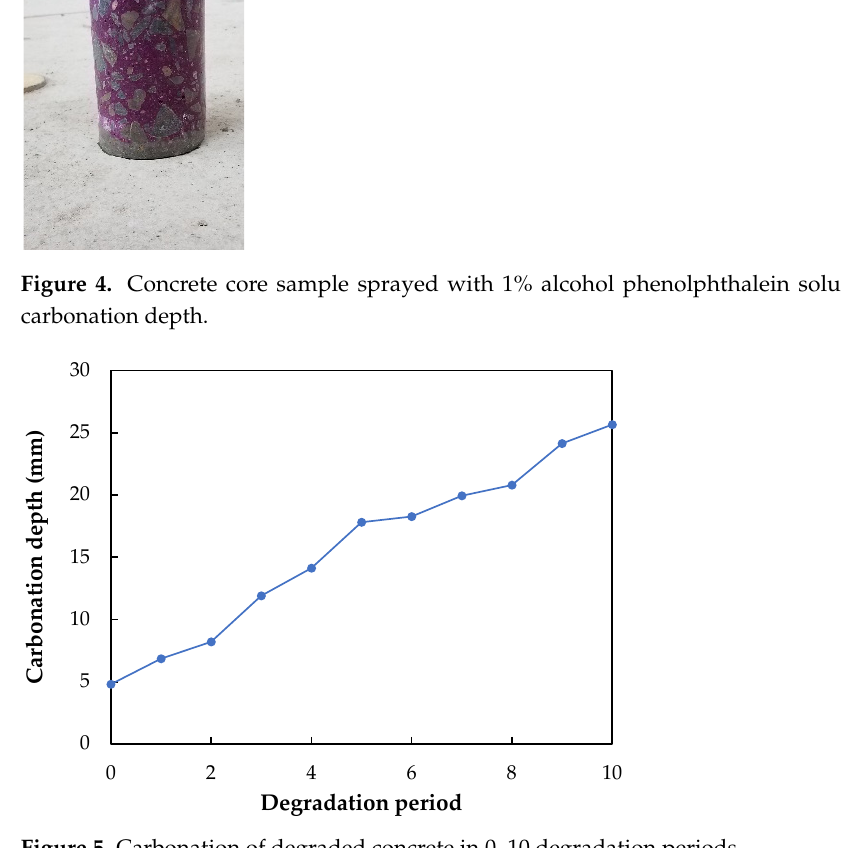
Figure 5. Carbonation of degraded concrete in 0–10 degradation periods.